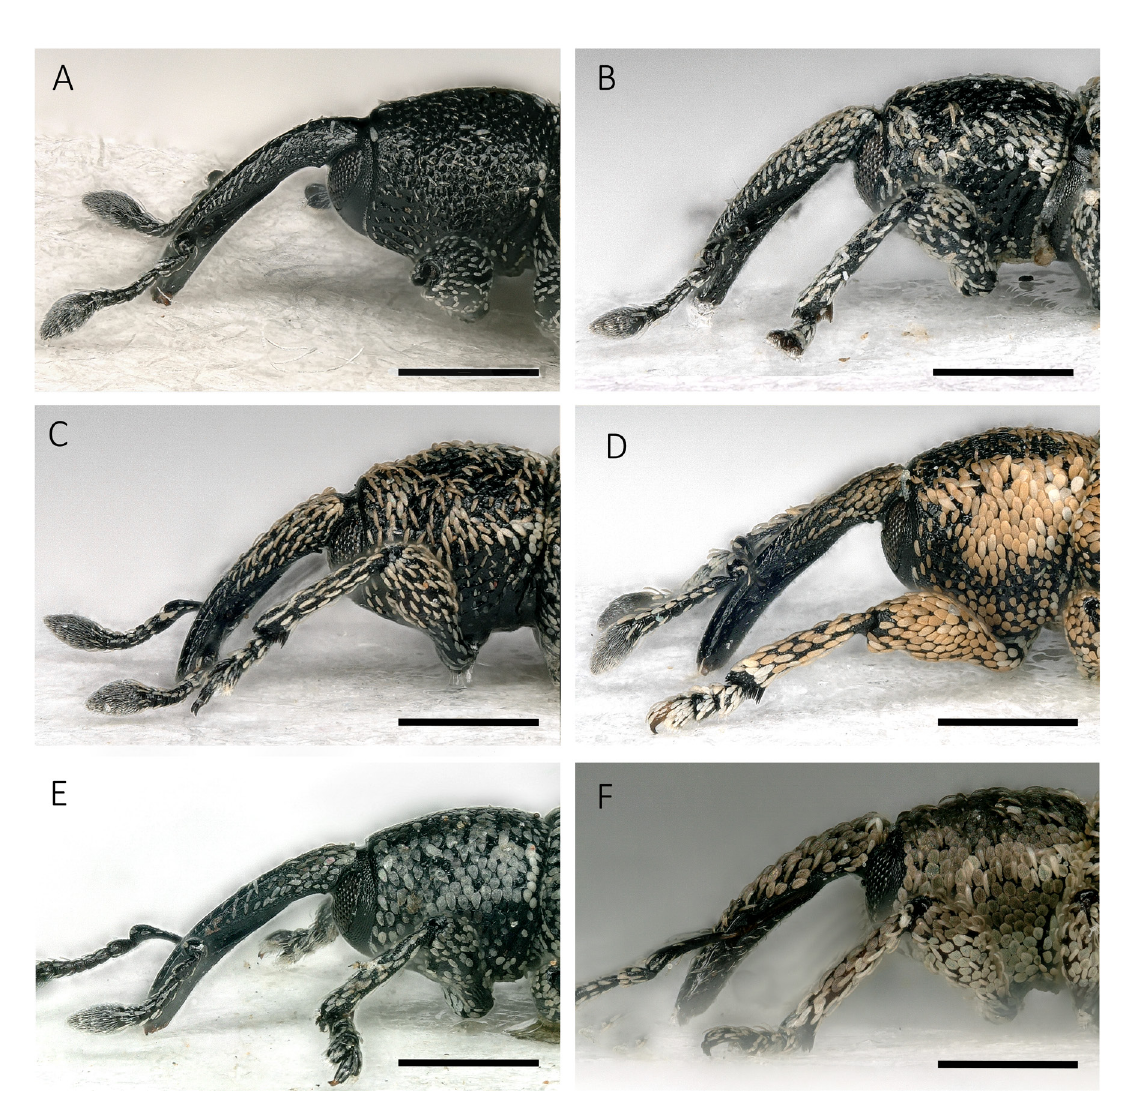
Fig. 4. Head and prothorax in lateral view of species of Smicronyx from southern Africa (Part 2). A . Smicronyx paucisquamis sp. nov., ♂, holotype (SAMC). B . Smicronyx fallax (Gyllenhal, 1836), ♂, neotype (NHRS). C . Smicronyx australis sp. nov., ♂, holotype (SAMC). D . Smicronyx san sp. nov., ♂, bred from Chironia baccifera L., holotype (SAMC). E . Smicronyx drakensbergensis sp. nov., ♂, holotype (TMSA). F . Smicronyx lutulentus Dietz, 1894, ♂ (CBGP). Scale bars: 0.5